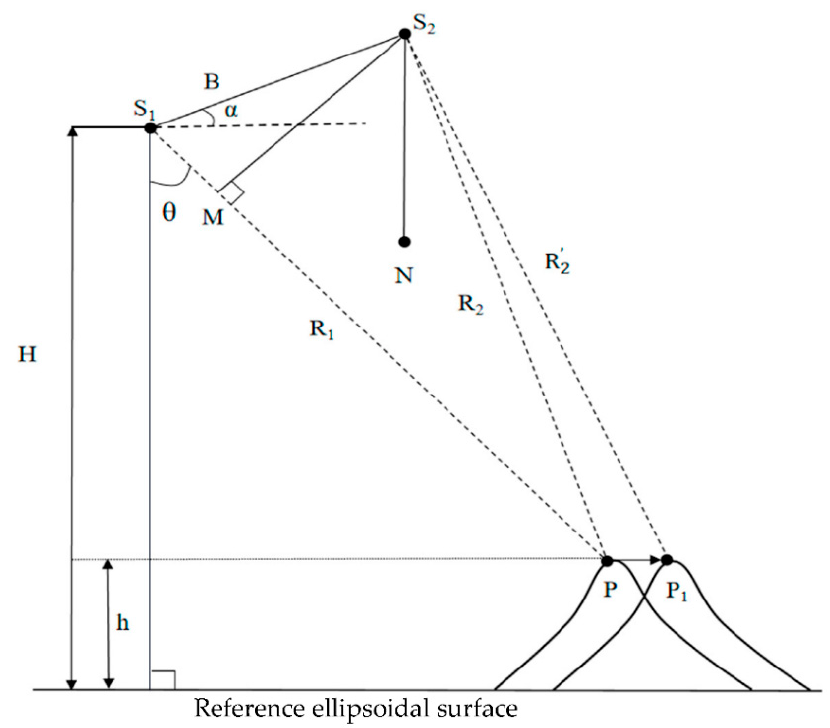
Figure 2. Model for InSAR interferometric geometry.